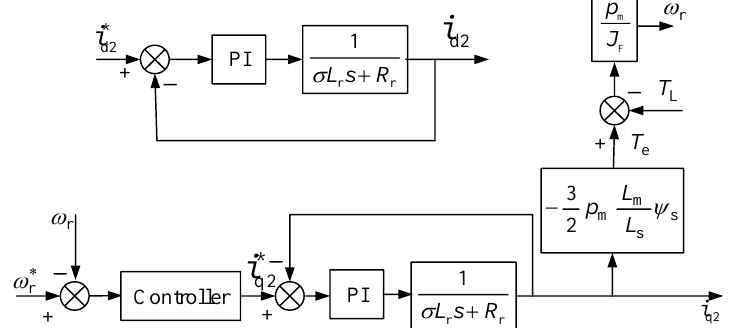
Figure 9. Complete block diagram of the rotor control system of a DFIG. * means the reference value. (1) The controlled object of the speed loop The simplified rotor inner current loop, i.e., Equation (9), is substituted into Figure 9. After further simplification, the dynamic structure diagram of the speed loop is shown in Figure